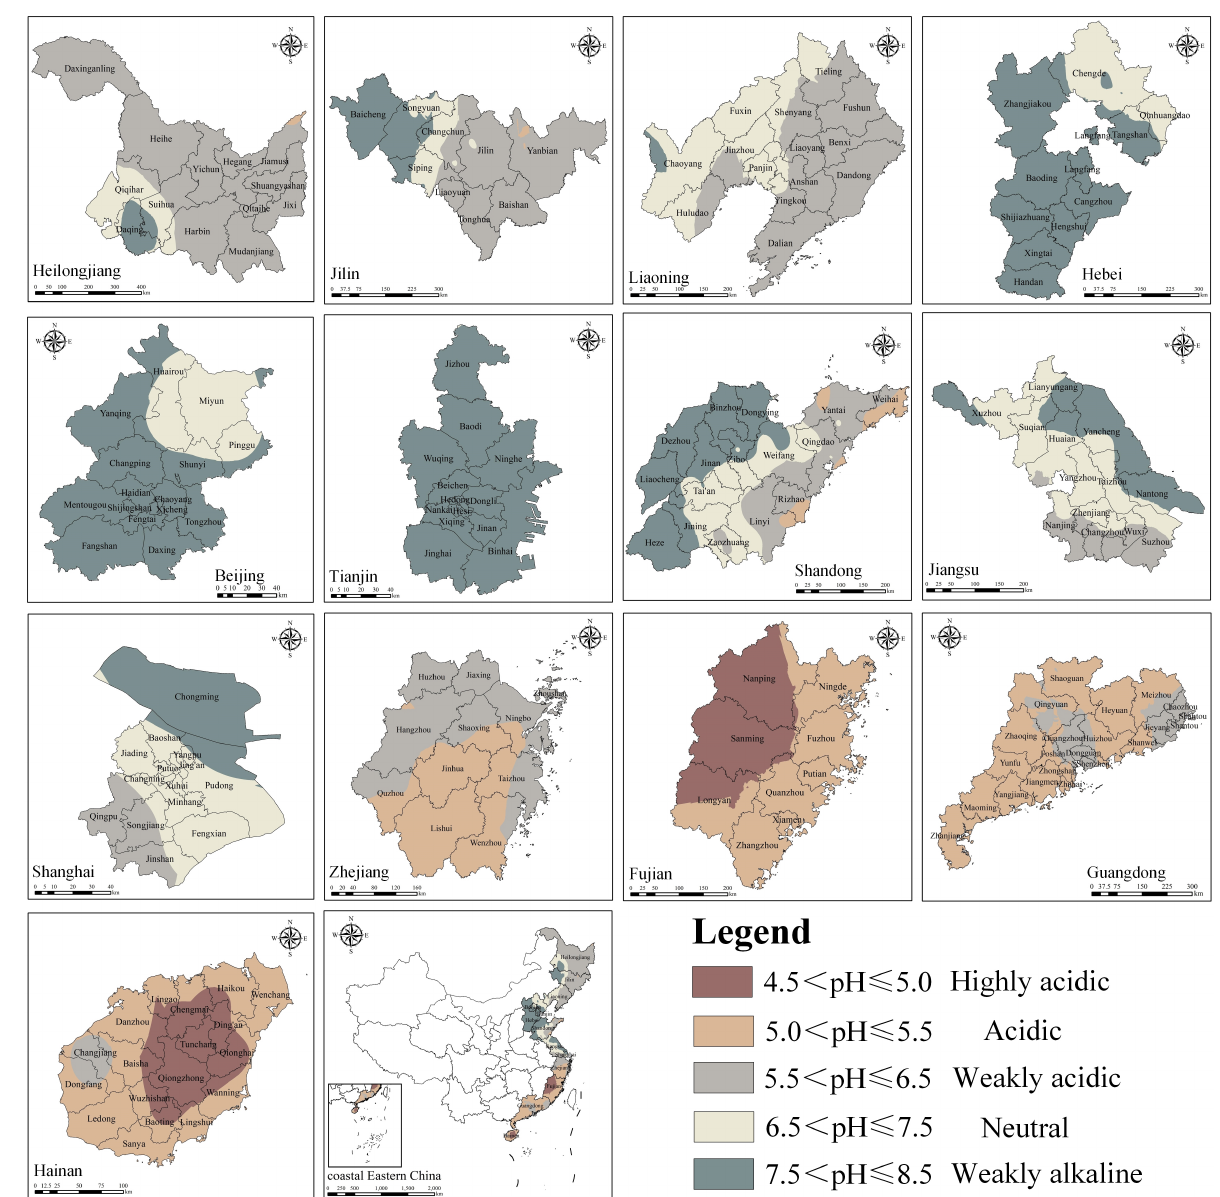
Figure 2. Spatial distribution of soil pH for each provincial